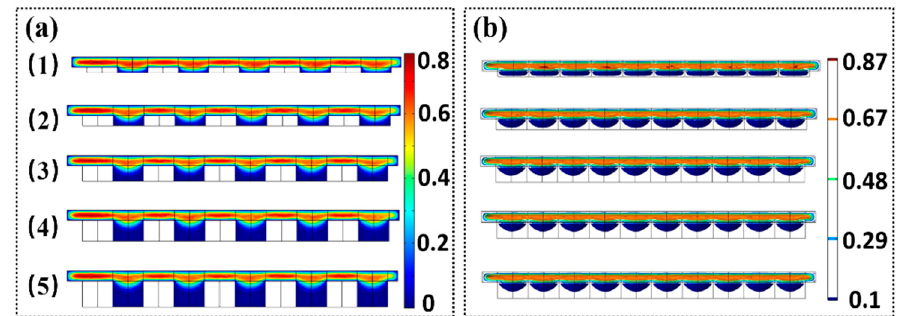
Figure 9. Cross section of flow field. ( a ) Flow field simulation results of the circular microwell arrays with radius of 30 µ m and heights of 10, 20, 30, 40, and 50 µ m. ( b ) Velocity contour distribution of the microwell flow field.